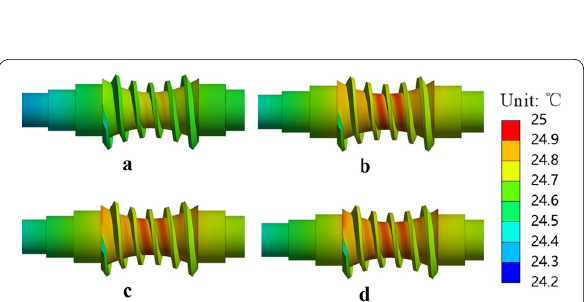
Figure 9 Temperature distribution of worm at different rotating speed: a 300 r/min, b 600 r/min, c 900 r/min, d 1200 r/min